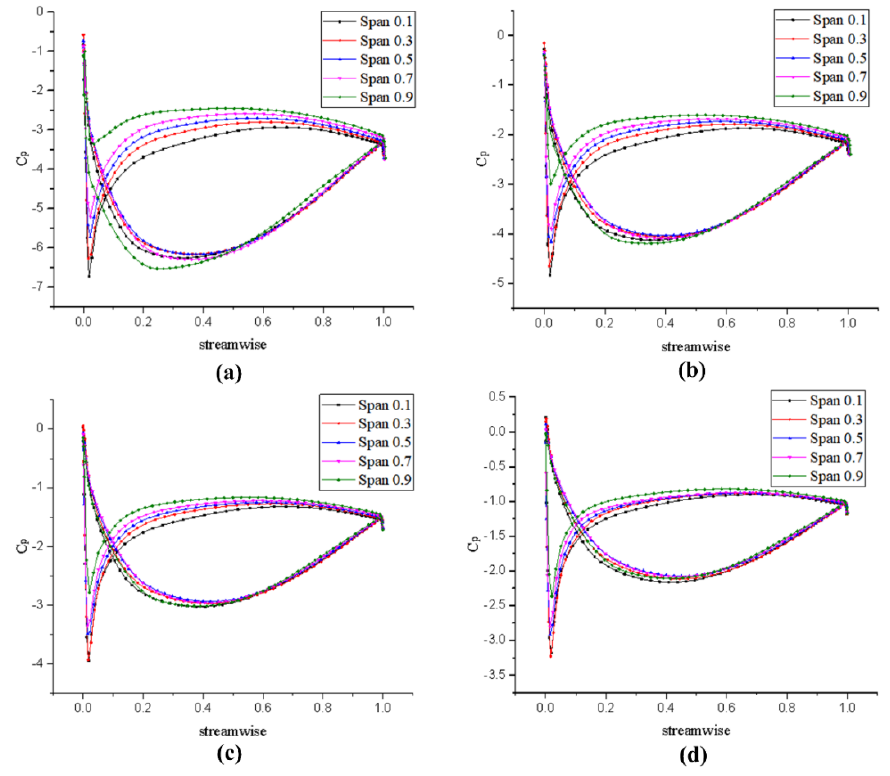
Figure 32. Tangential pressure distribution of stator designed by inverse design method: ( a ) v = 7 m/s ( J = 0.78), ( b ) v = 8.5 m/s ( J = 0.95), ( c ) v = 10 m/s ( J = 1.12), and ( d ) v = 11.5 m/s ( J = 1.28).